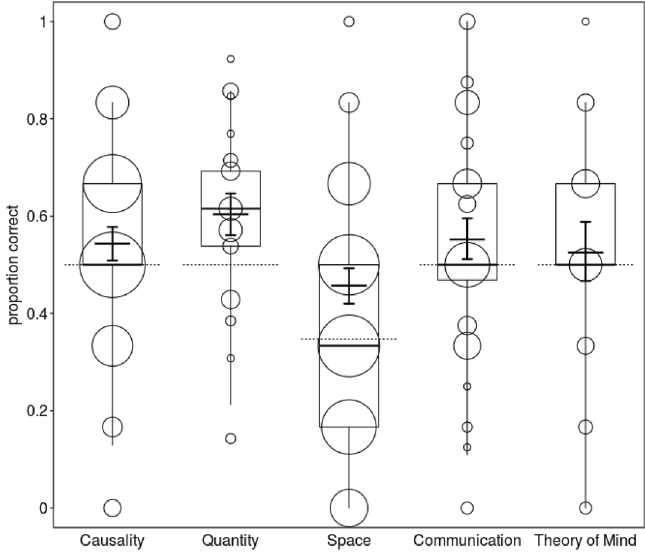
Figure 3 Correct responses as a function of cognitive scale. The figure shows the proportions of correct responses as a function of cognitive scale. Dots represent the amount of observations per proportion correct (N = 1 to 88 tests). Indicated are median (horizontal lines), quartiles (boxes), and percentiles (2.5 and 97.5%, vertical lines). The crosses represent the fitted model and its confidence limits (conditional on all covariates and factors centred to a mean of zero). The doted horizontal lines depict chance